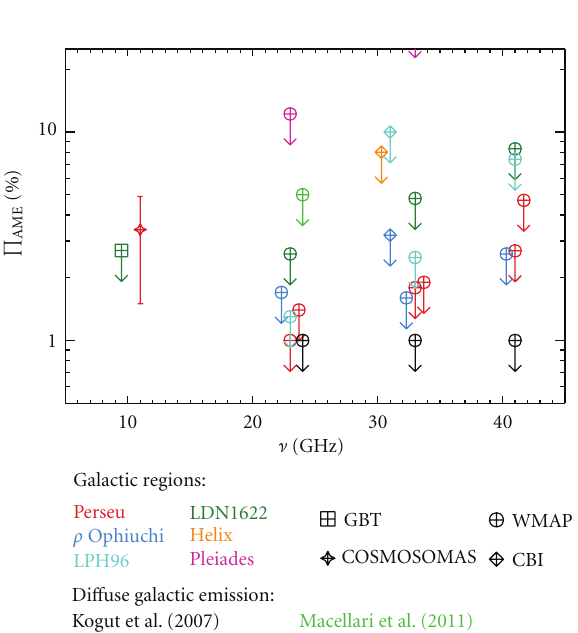
Figure 2: Summary of the current constraints on the fractional polarisation ( Π ) of the AME. Data points are taken from Table 1. All upper limits are given at the 95% confidence